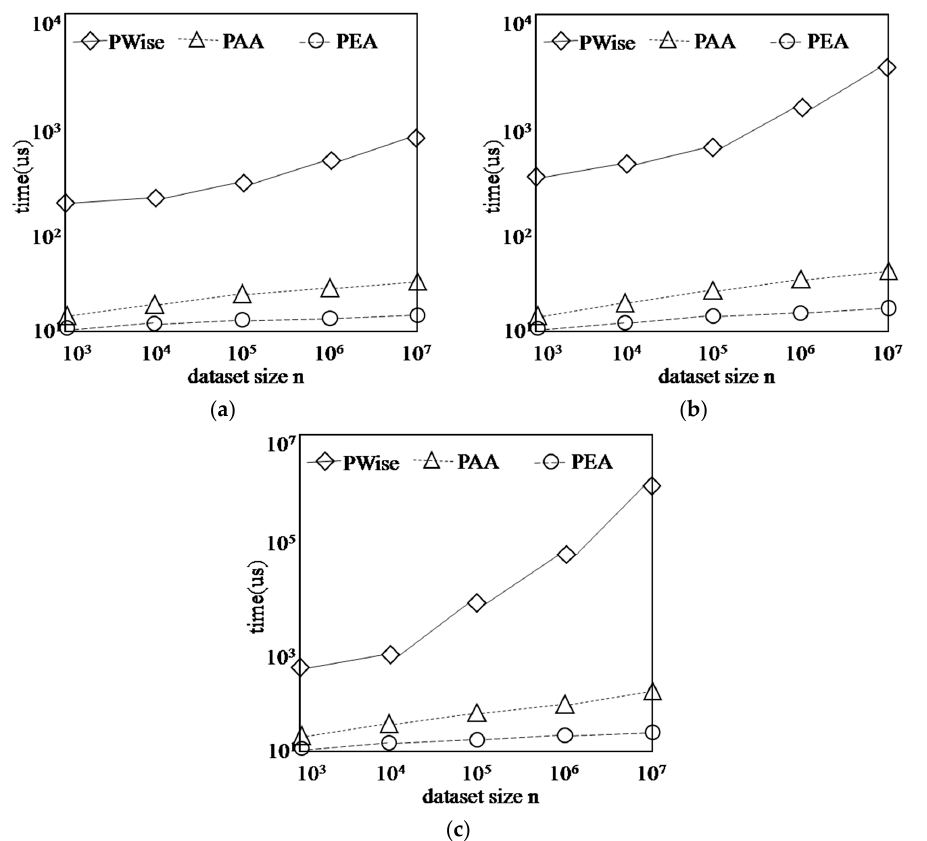
Figure 14. Finding G-Skyline with different dataset size n . ( a ) COR; ( b ) IND; ( c ) ANTI-COR.